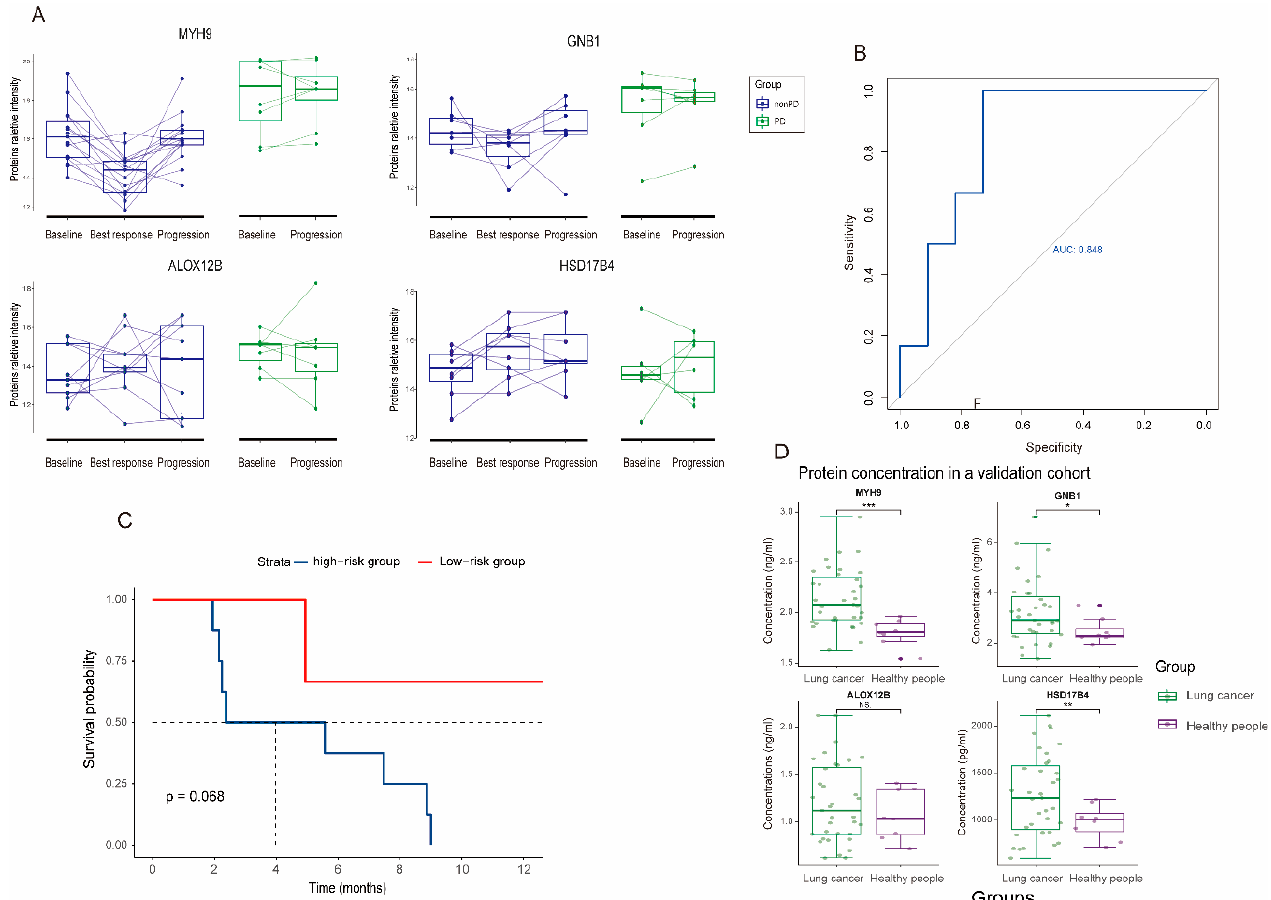
Figure 5. Dynamic change and validation of four biomarker candidates in the prediction of response to MET inhibitors. ( A ) Longitudinal relative proteins intensity at baseline, best response, and progression between non-PD and PD groups. ( B ) Validation of four biomarker candidates in another cohort of MET dysregulated NSCLC patients using plasma ELISA method. ( C ) Kaplan–Meier plots of progression-free survival based on the four-protein signature in the validation group. ( D ) Boxplots of concentrations of the four proteins in lung cancer patients and healthy people. * p value < 0.05, ** p value < 0.01, *** p value < 0.001.